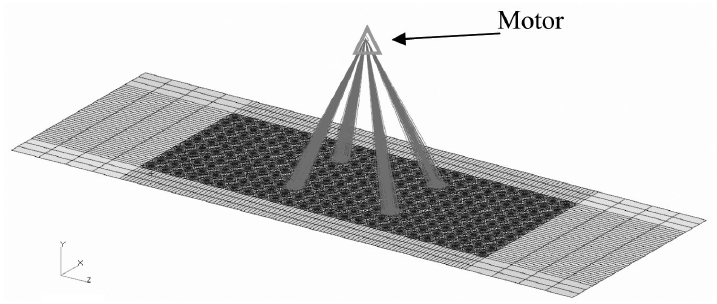
Fig. 52. Elasto-inertial dynamic layer attached to a plate with a vibrating